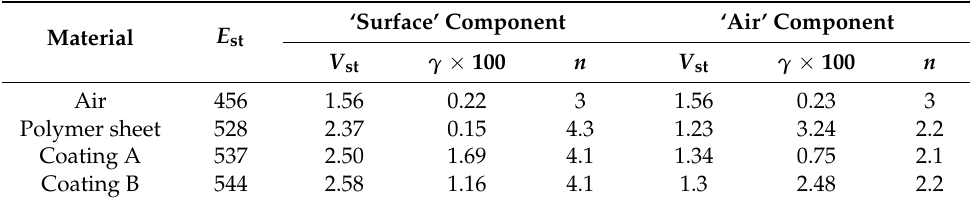
Figure 9. Velocities of the ‘air’ components under the varied electric fields. Table 1. Corresponding parameters in Equation (3).